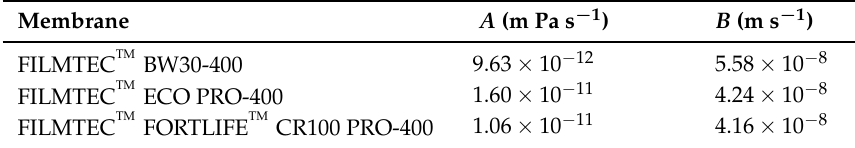
Table 1. Calculated permeability